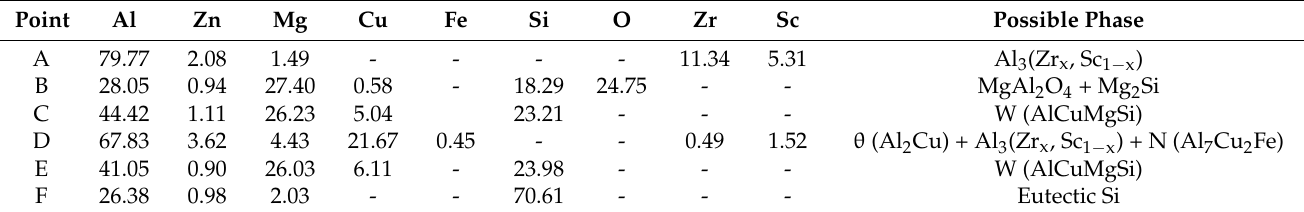
Figure 18. SEM backscattered photograph of an enlarged part of solid–liquid bonding interface in T6 status and its EDS surface scanning results. ( A – F are the EDS scanning points.) Table 4. EDS analysis of each point indicated by the arrow in Figure 18 (at.%).